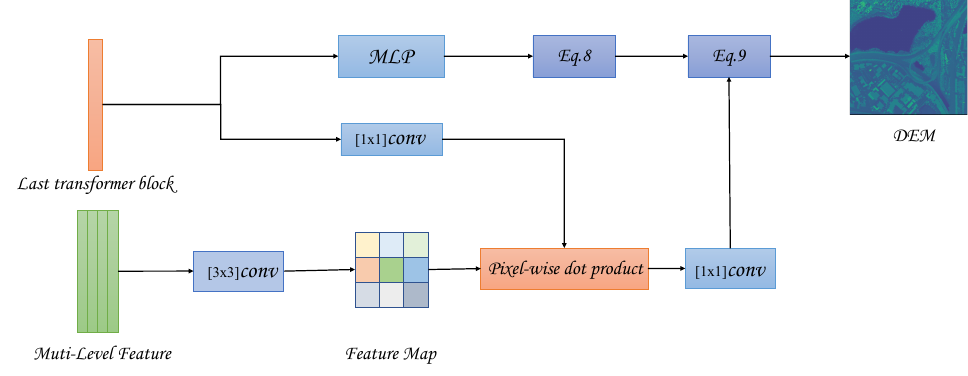
Figure 9. Relative height estimation